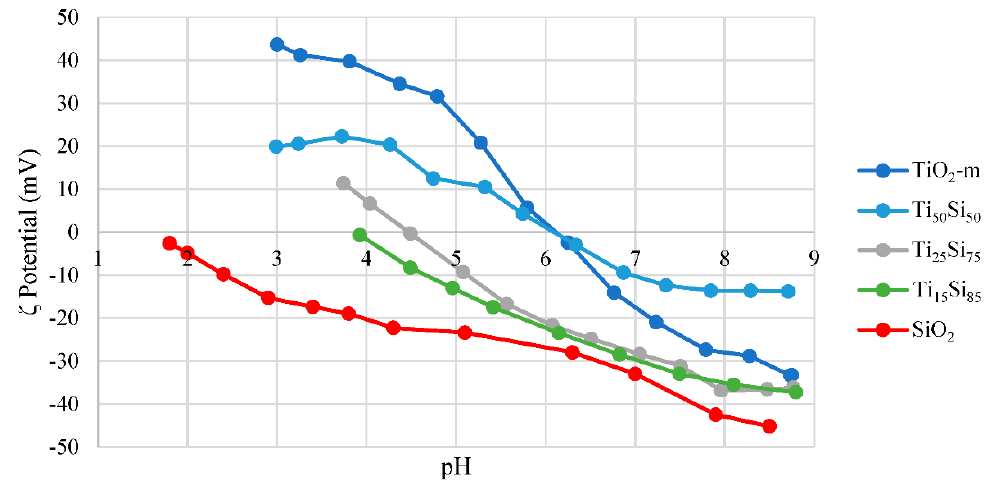
Figure 1. ζ -potential titration of titania-silica suspensions before spray-freeze drying.